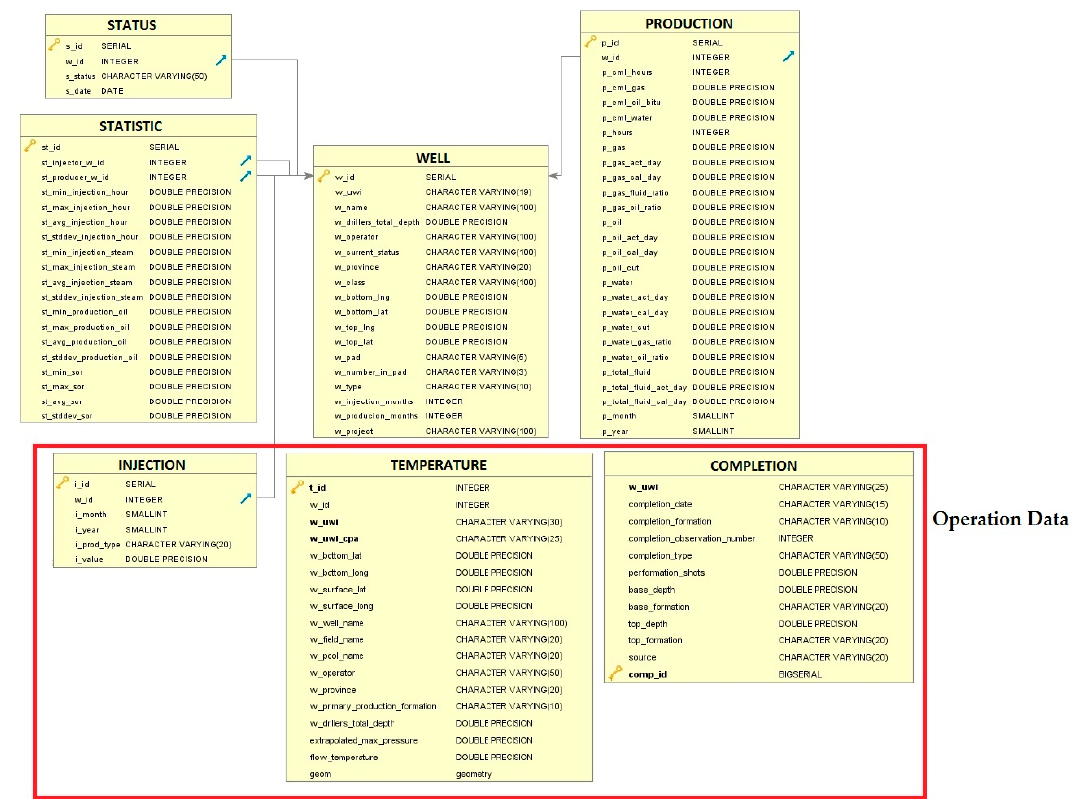
Figure 3. Five types of data are stored in the OGVES database: WELL, STATUS, STATISTIC, PRODUCTION and OPERATION tables.